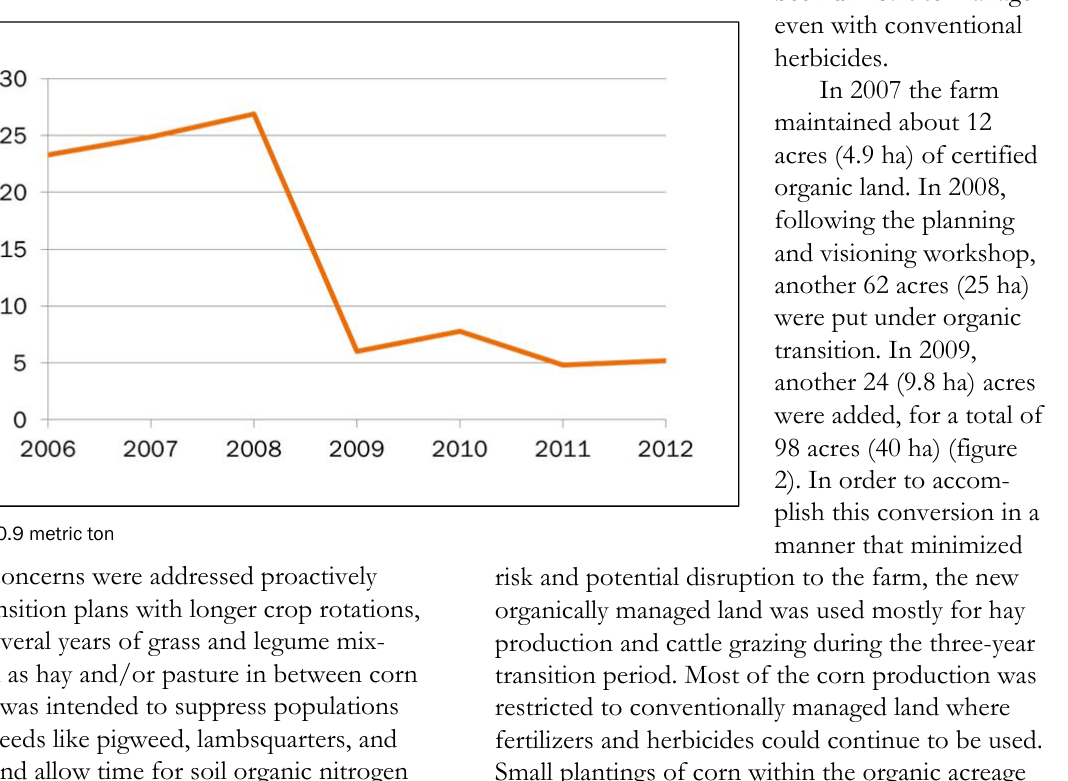
Figure 3. Synthetic Fertilizer Use on the Berea College Student Farm,